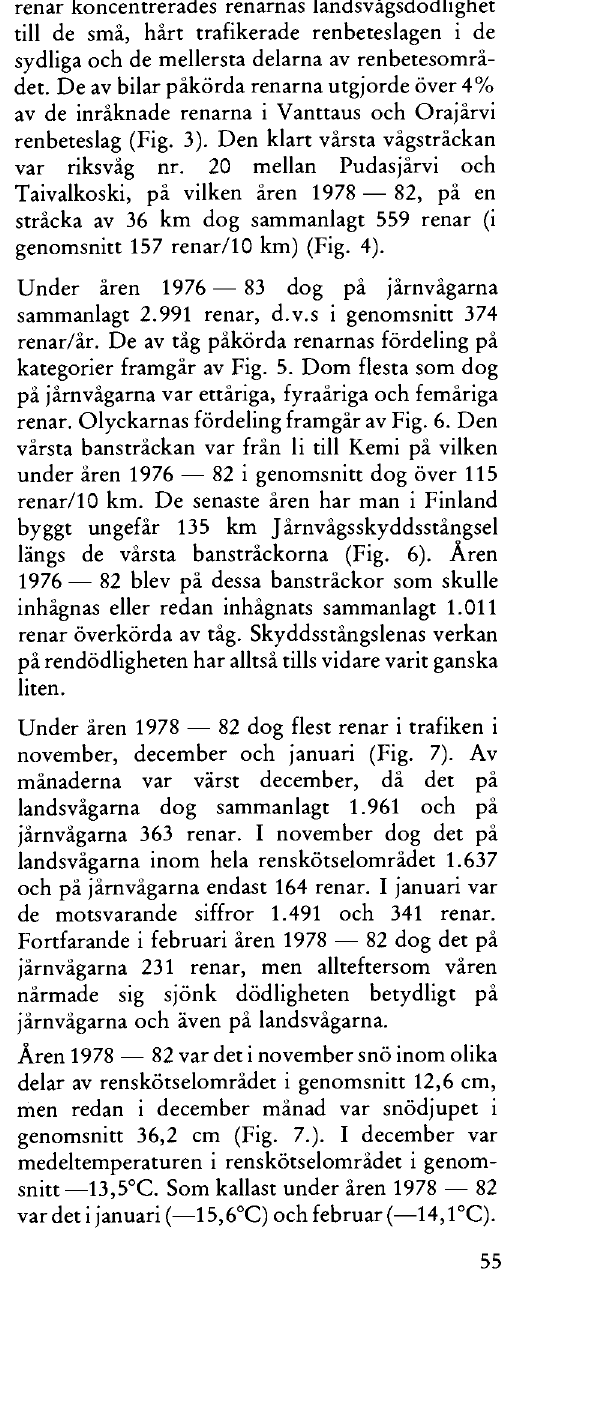
Fig. 3. The share of herding area counted reindeer (%) killed by vehicles during 1978 — 82. Over 4% of the counted reindeer in the Vanttaus and Orajdrvi herding areas